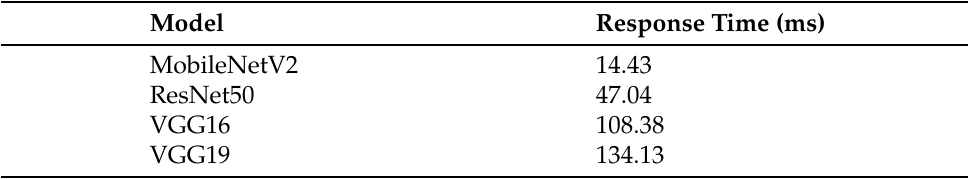
Table 3. Response time of the models.